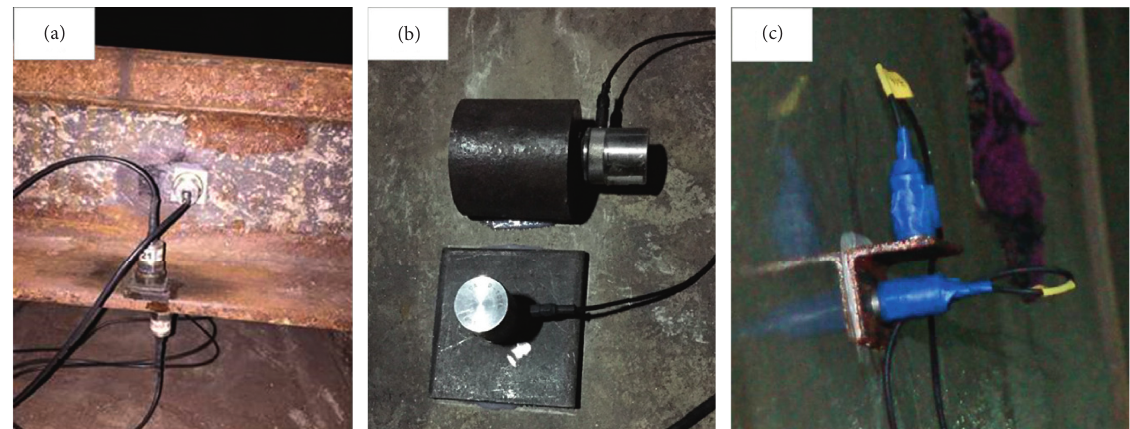
Figure 5: Accelerometers installed on the (a) rail, (b) track bed, and (c) tunnel